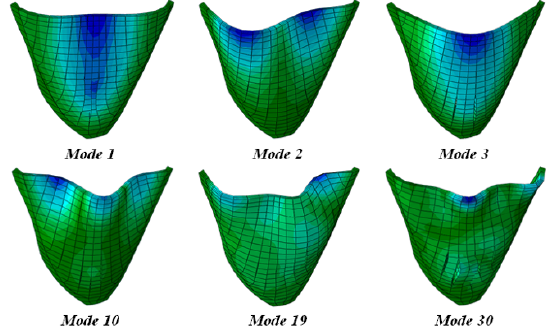
Figure 12. Modesshapespertinenttosomenaturalvibrationsofthe dam body; NL-DCM